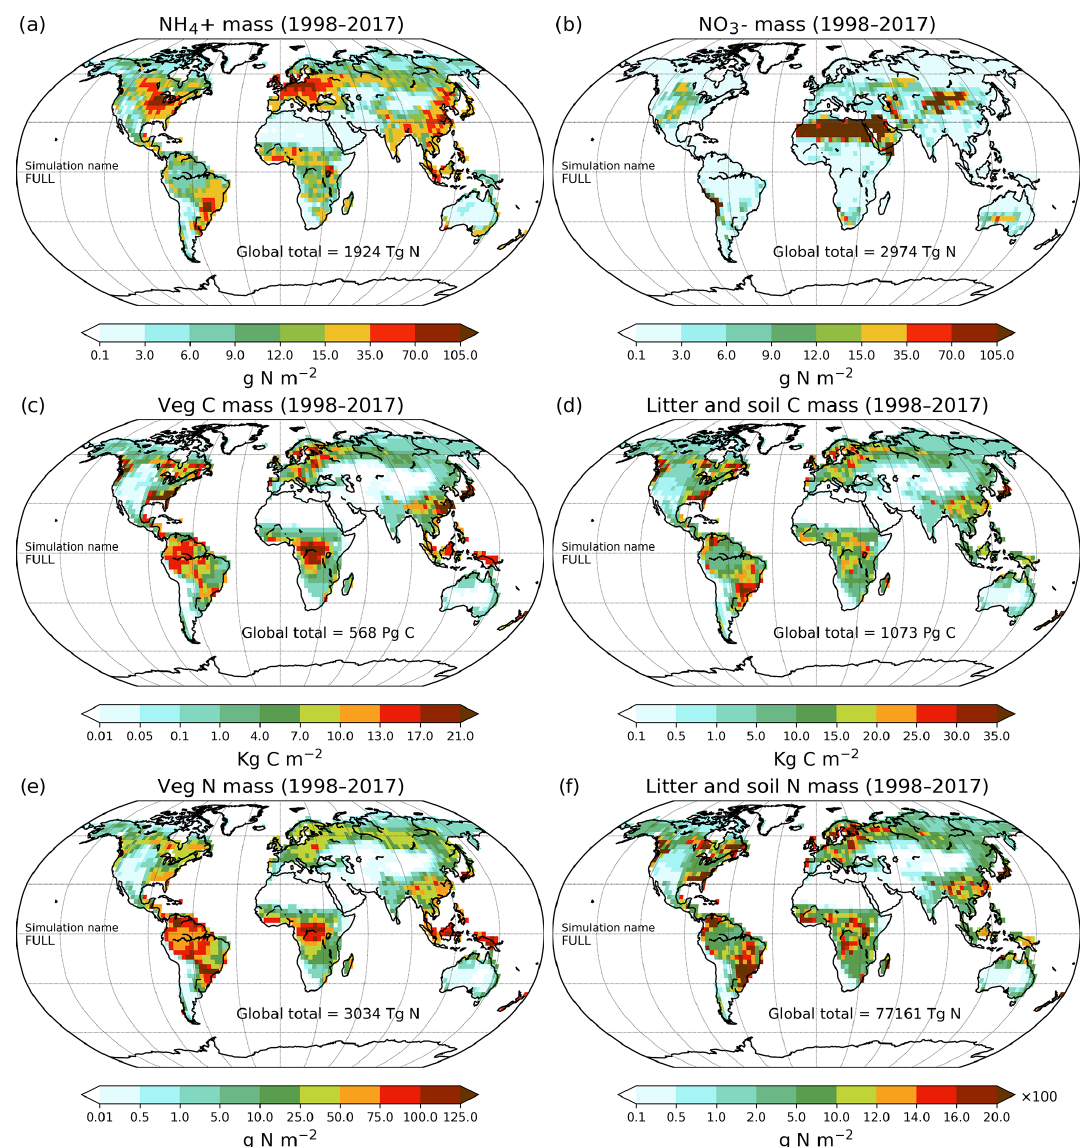
Figure 9. Geographical distribution of primary C and N pools. Ammonium (a) , nitrate (b) , vegetation C mass (c) , litter and soil C mass (d) , vegetation N mass (e) , and litter and soil N mass (f) . The global total values shown are averaged over the 1998–2017